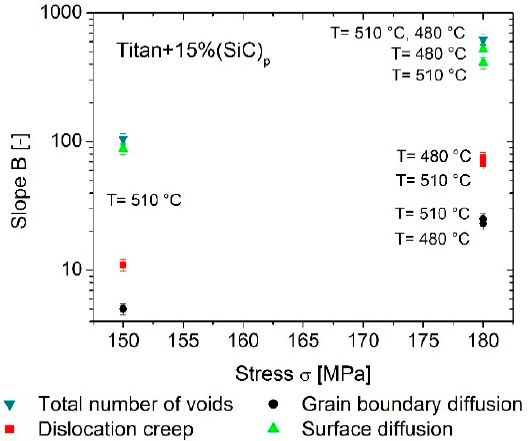
Figure 11. Ti-MMC, void formation, early creep stage, linear fit.